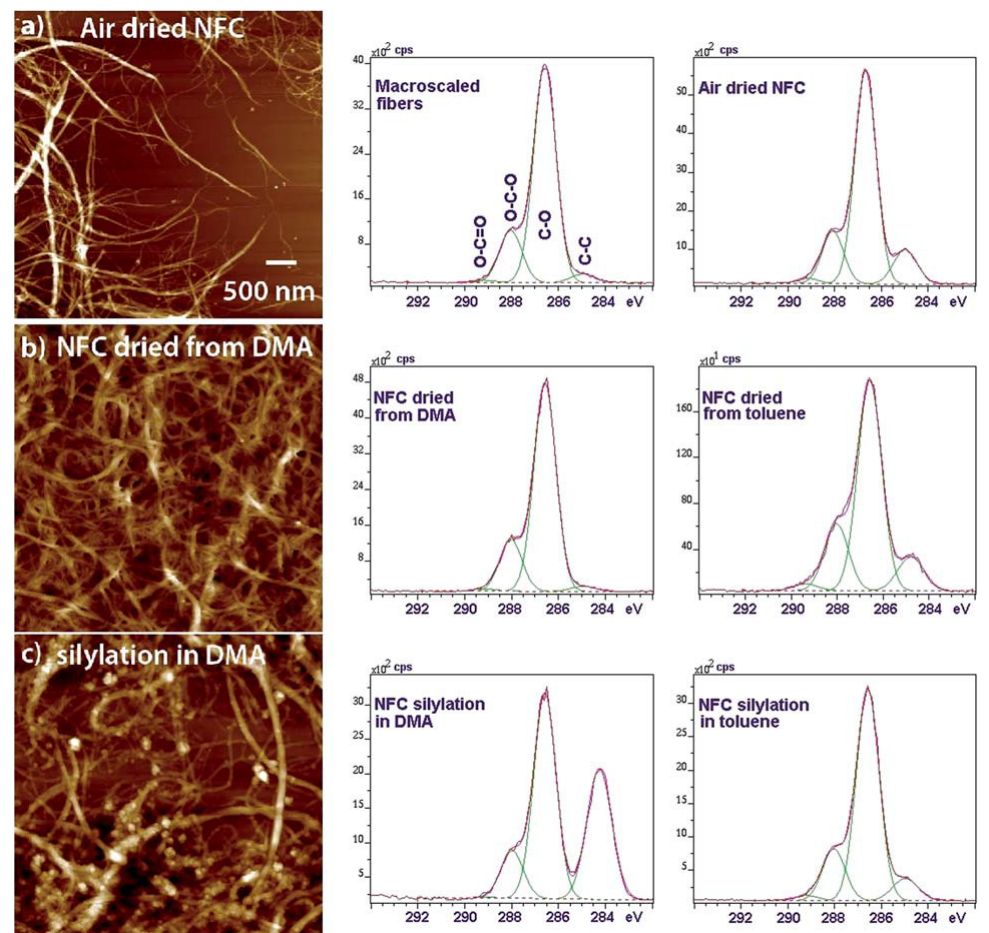
Figure 7. AFM and XPS data for neat and silylated NFCs, in DMA and toluene. Principle of “surface adaptation” (Reproduced from Johansson et al. 2011 [58].